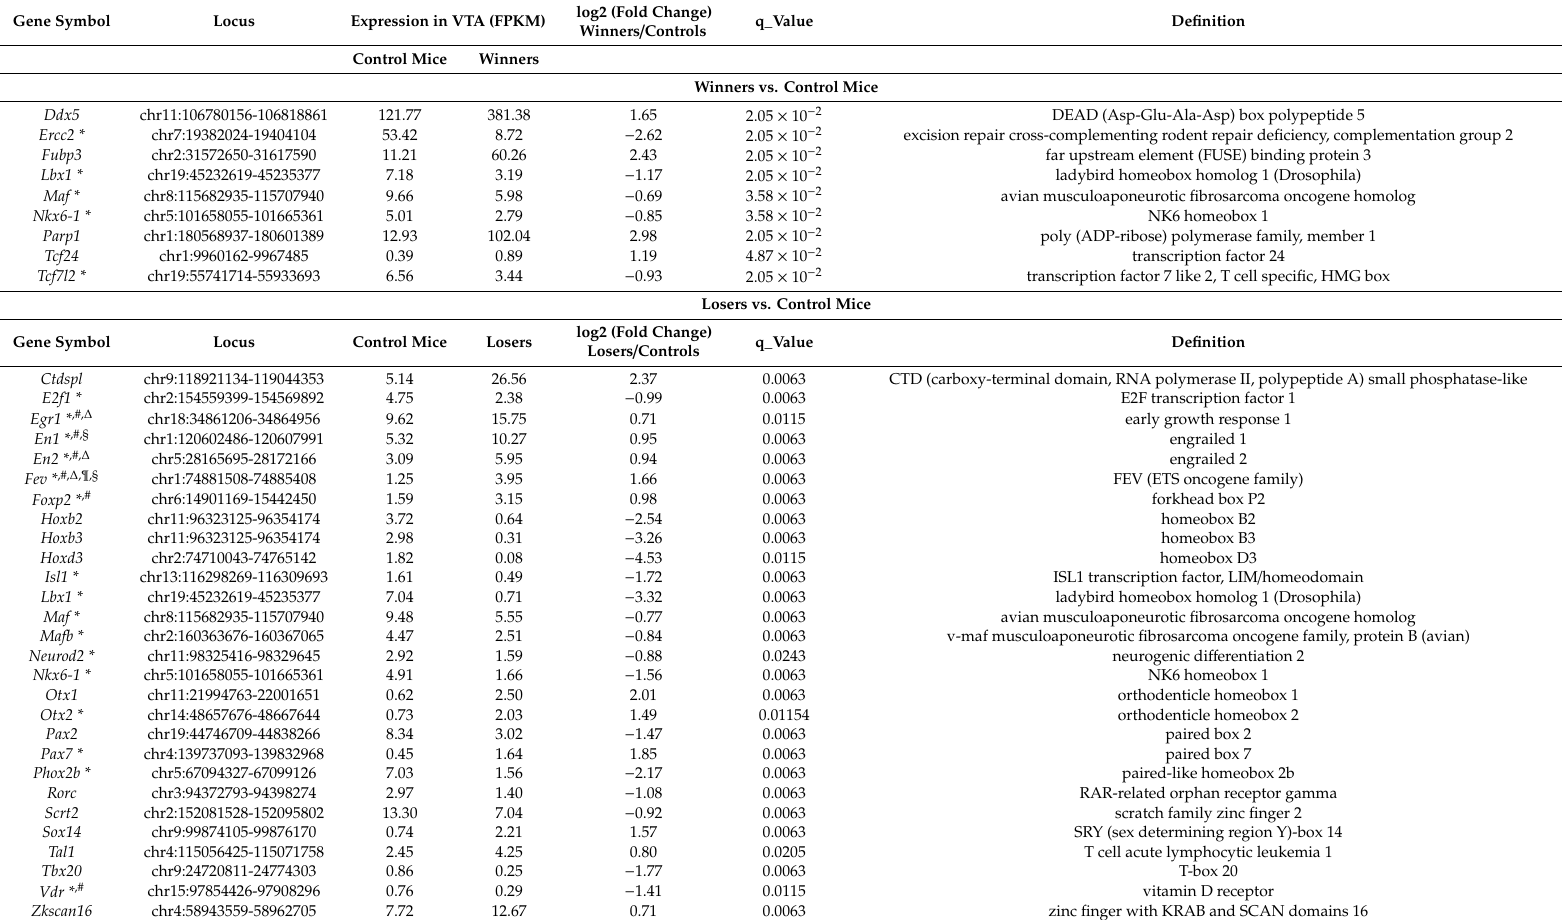
Table 2. DEGs encoding transcription